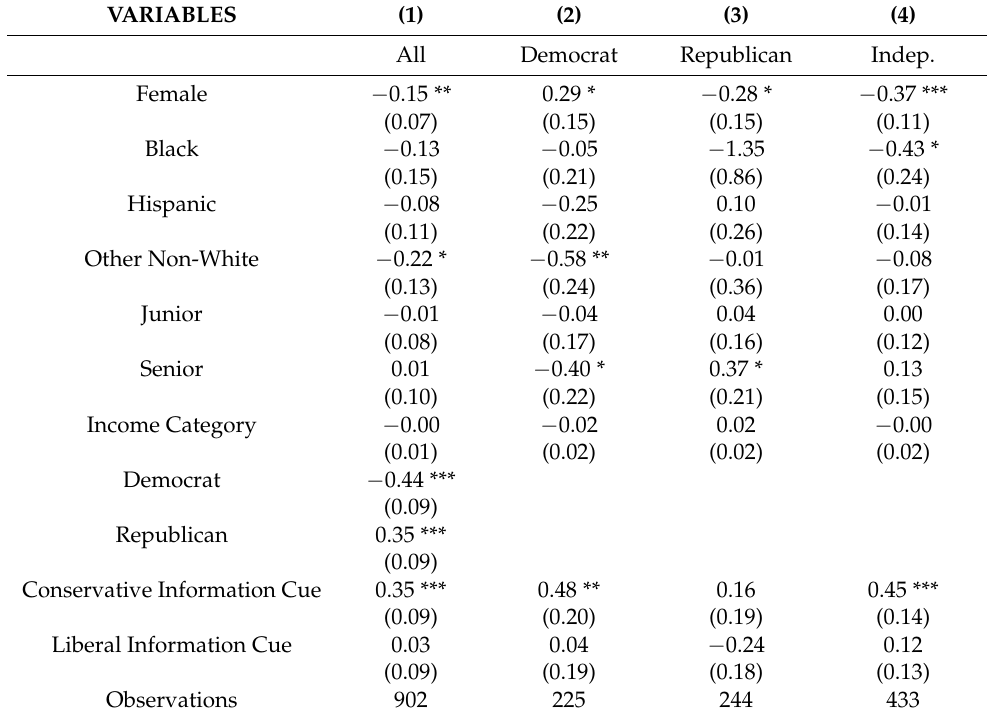
Table 8. Information cues and attitudes towards gun control laws. Ordered probits: dependent variable is degree of agreement with the statement that “gun control laws in most states are too